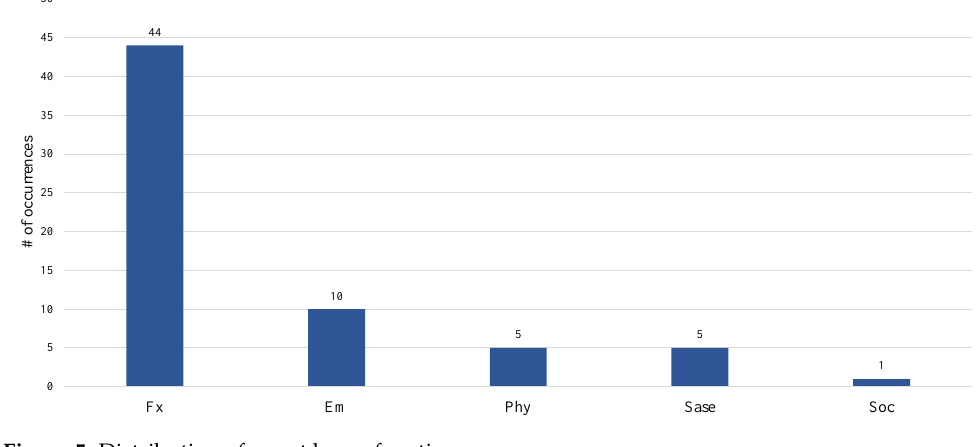
Figure 5. Distribution of smart home